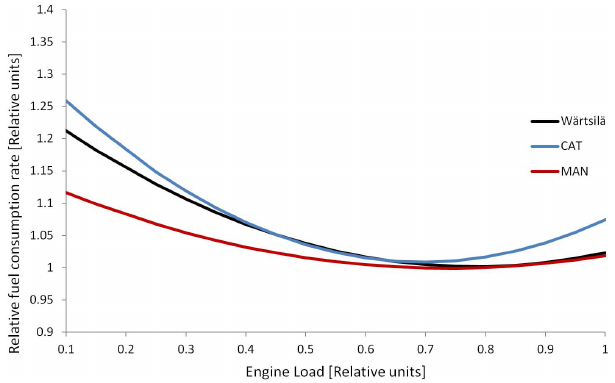
Fig. 2. The relative specific fuel-oil consumption (SFOC) as a func- tion of the relative engine load, based on the data of three engine manufacturers: W¨artsil¨a, Caterpillar and MAN. The data of Cater- pillar is based on three different SFOC-curves of small four-stroke engines (see Appendix B, Table B3), and the data of MAN is based on large two-stroke engines (see Appendix B, Table B2). W¨artsil¨a data for “46” engine family was used (see Appendix B, Table B1). A more detailed description of the data is presented in the main text and in Appendix